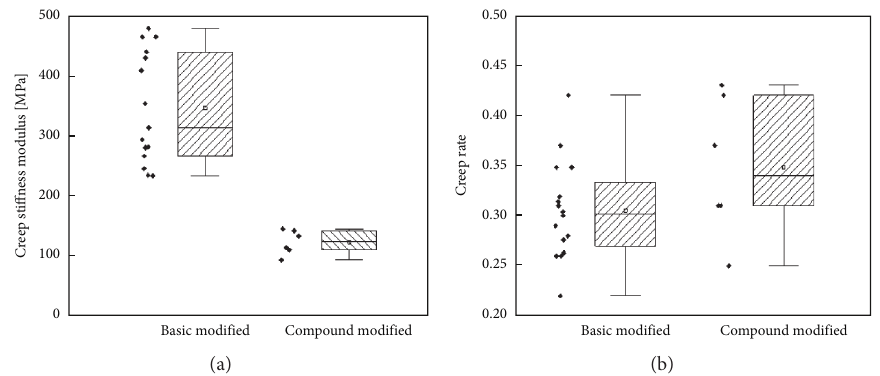
Figure 6: Creep stiffness modulus and creep rate of high modulus asphalt: (a) creep stiffness modulus; (b) creep